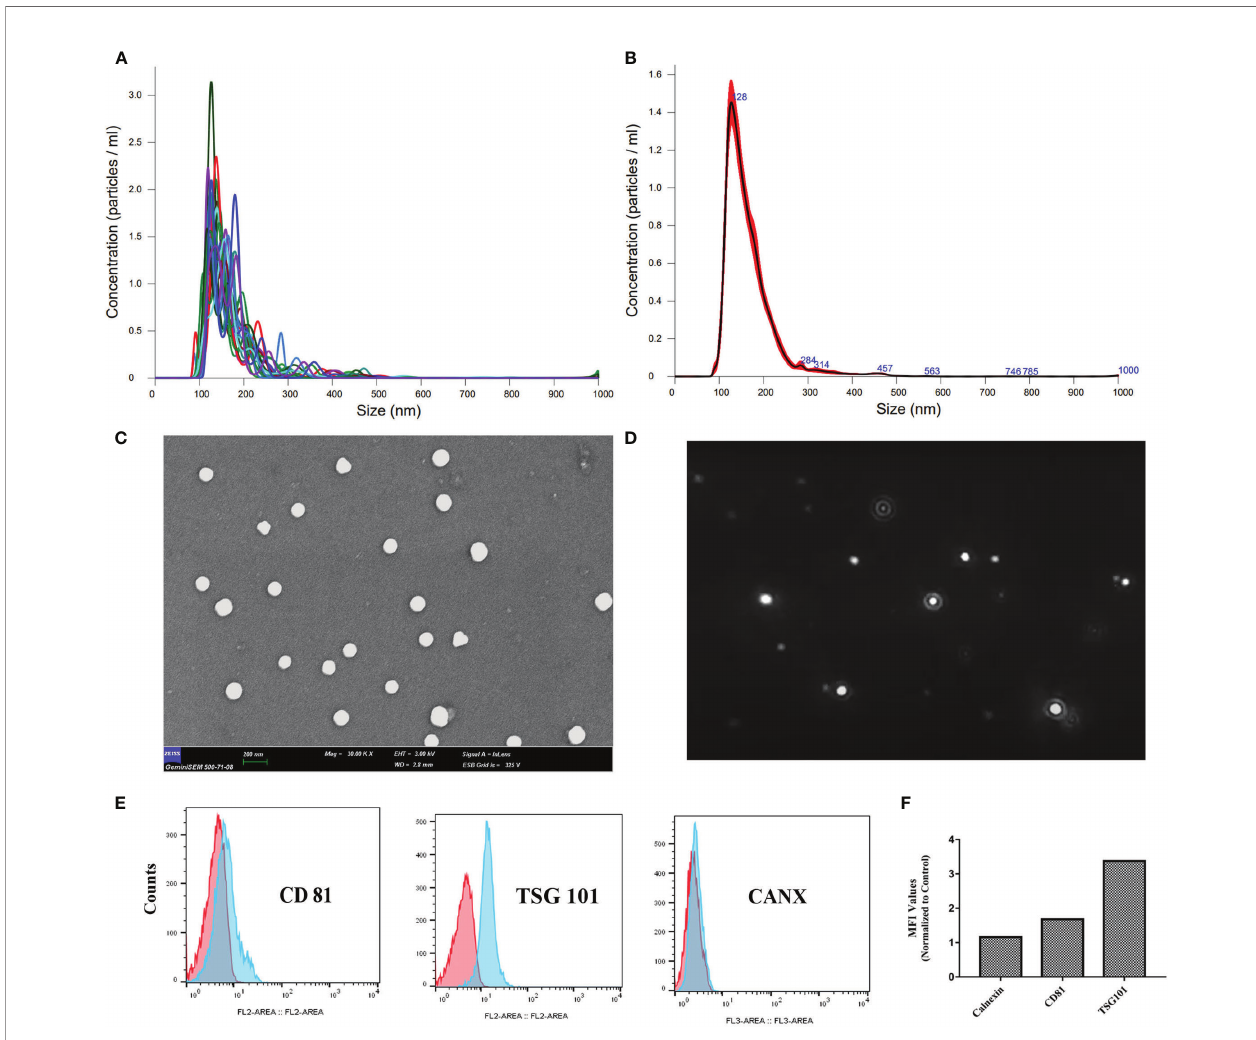
FIGURE 1 | Characterization of convalescent human immune plasma-derived exosomes (ChipEXOs). (A) Individual size distribution measurements. (B) Mean size distribution measurements. (C) SEM micrograph. (D) Dynamic light scattering image. (E) Bead-assisted fl ow cytometry measurements of key exosome markers (CD81 and TSG 101) and a negative control marker (CANX). (F) Geometric MFI values are provided above the peaks. MFI, mean fl uorescent